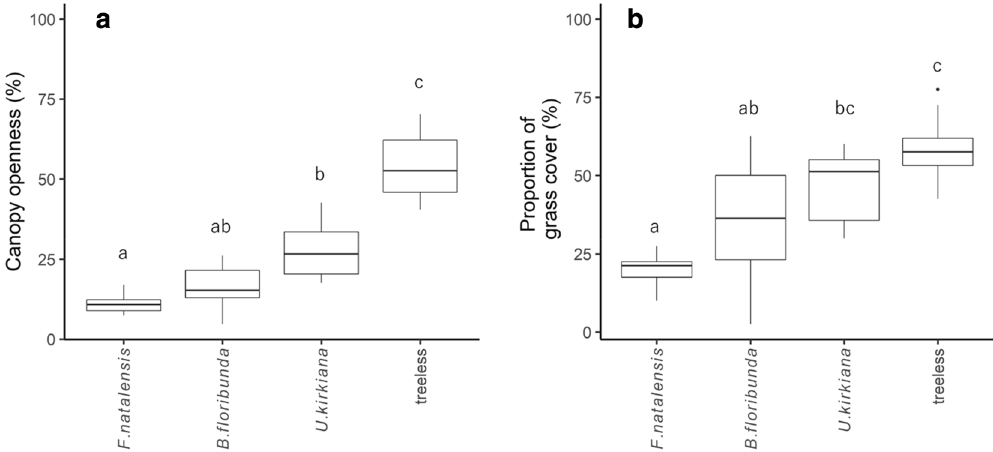
Figure 1. Boxplots of ( a ) canopy openness (n = 40) and ( b ) percentage of grass cover (n = 40) in northern Malawi. All microsites were located in miombo woodlands. Different letters indicate significant differences ( P < 0.05) among the microsites based on Steel–Dwass post hoc tests.